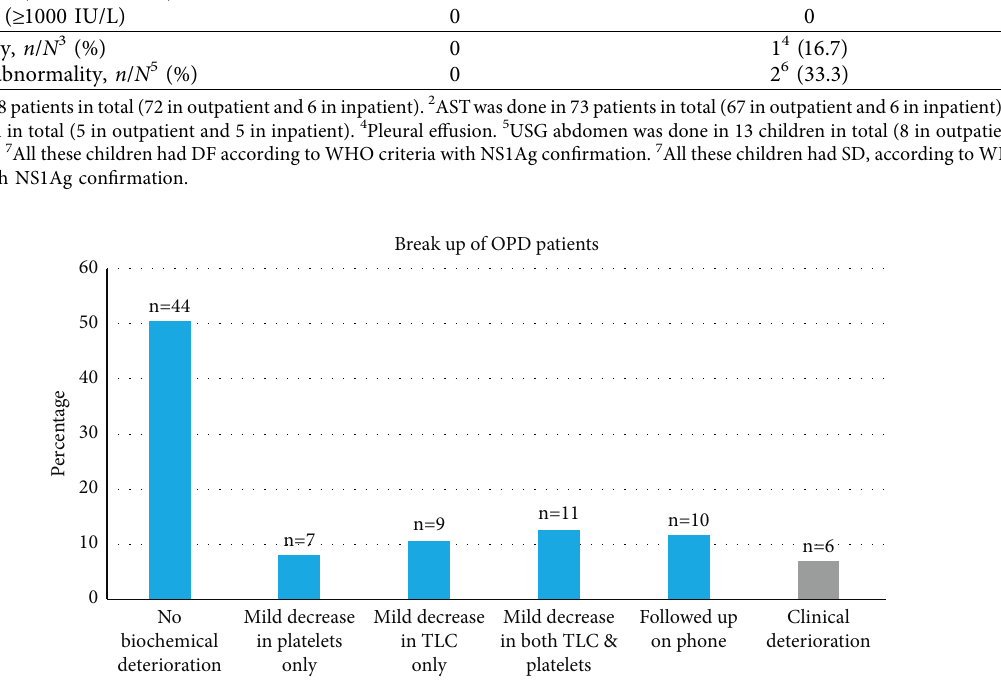
Figure 2: Clinical and biochemical characteristics of children with dengue fever who received outpatient treatment ( n � 87). Despite mild biochemical abnormalities, no clinical deterioration occurred in 44/87 (50.5%) of patients. Five patients developed warning signs and one SD and were successfully